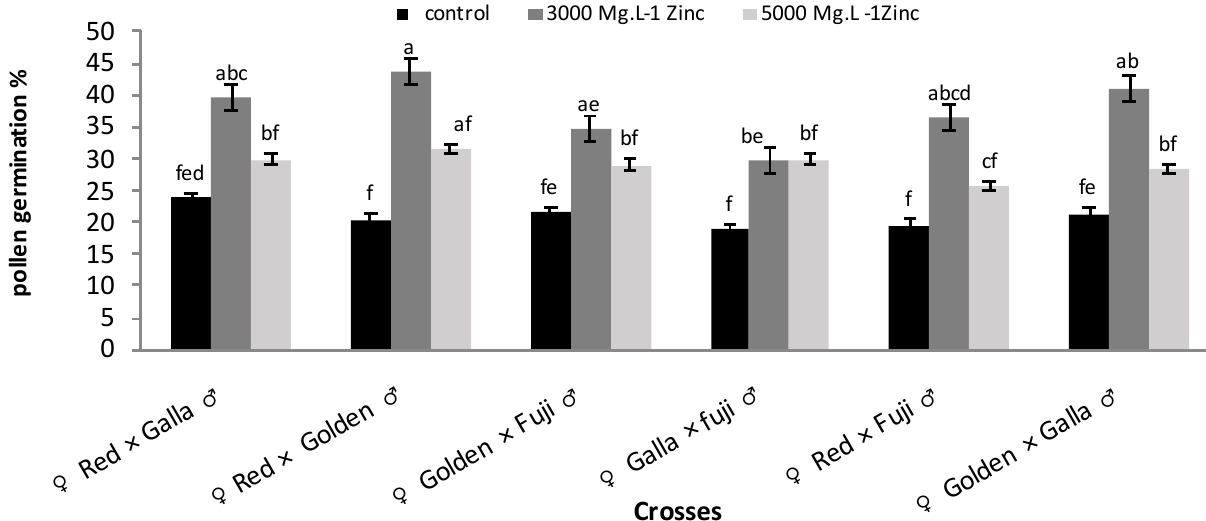
Fig 2. The interaction between Zn concentration and crosses on the pollen germination on the stigma in different crosses. Means in each column, followed by similar letter (s) are not significantly different at 1% probability level.